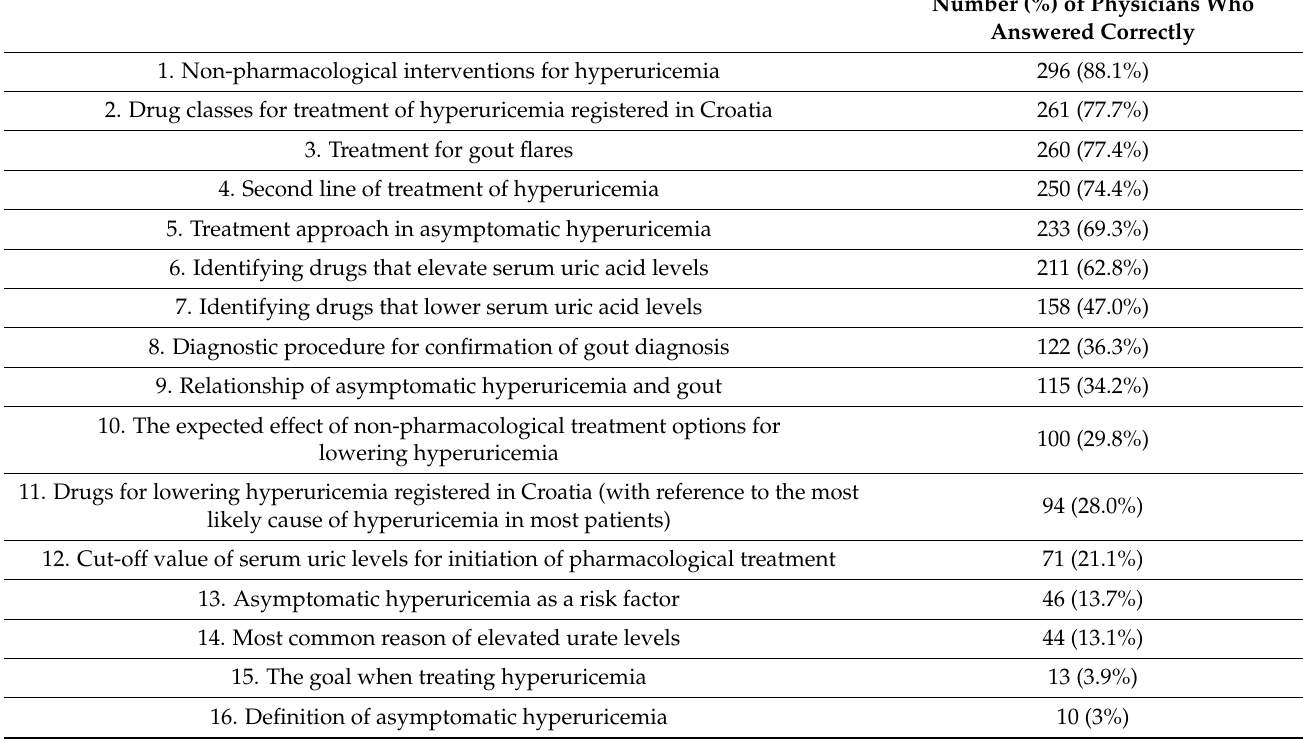
Table 4. Physicians who answered correctly to questions related to asymptomatic hyperuricemia and gout.